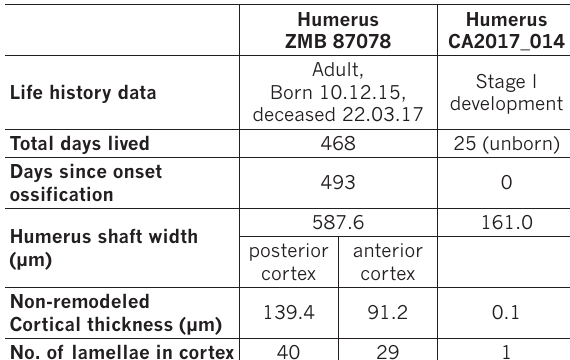
Table 2. Histomorphometric data obtained from humeri of an adult (ZMB 87078) and a ‘stage I’ (CA2017_014). These data were used to calculate average apposition and lamellar bone ac- cretion